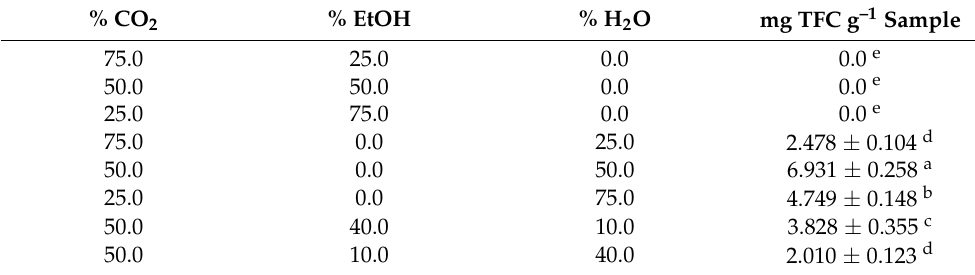
Table 1. TFC concentration obtained from the different water, ethanol and ethanol:water proportions with respect to CO 2 flow (20 mL min − 1 ) while at constant temperature and pressure conditions: 65 ◦ C and 150 bar ( n =